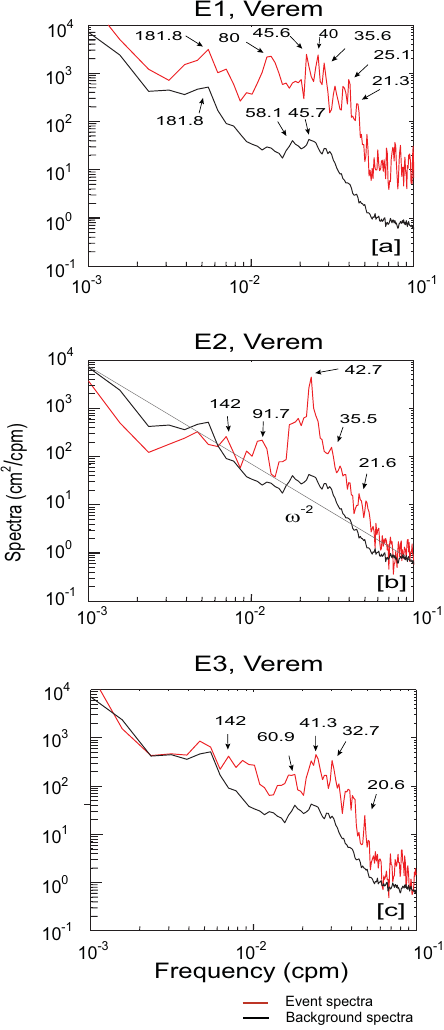
Fig. 6. Sea level residual (SLR) spectra at Verem during differ- ent events (red) along with the corresponding background spectra (black) (a) E1 over 3 days (Julian days 174–176, N = 864), (b) E2 over 3 days (Julian days 255–257, N = 864) and (c) E3 over 4 days (Julian days 313–316, N = 1152). N represents the number of data samples used in estimating the spectra. The number associated with significant peaks is time period in